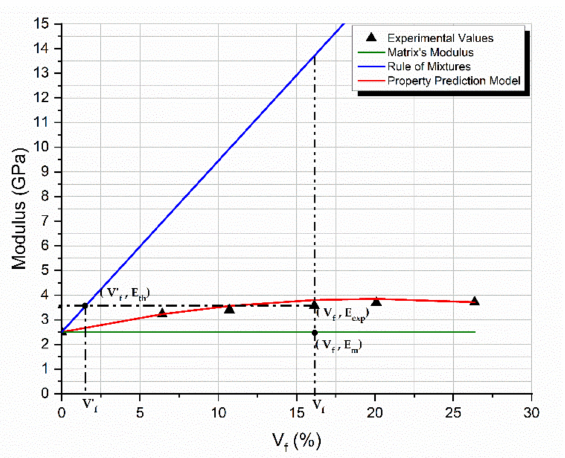
Figure 1. Experimental values of the stiffness variation with the filler-volume fraction of a particulate composite, along with the matrix modulus, E m , the rule of mixtures prediction, E th , and the respective PPM